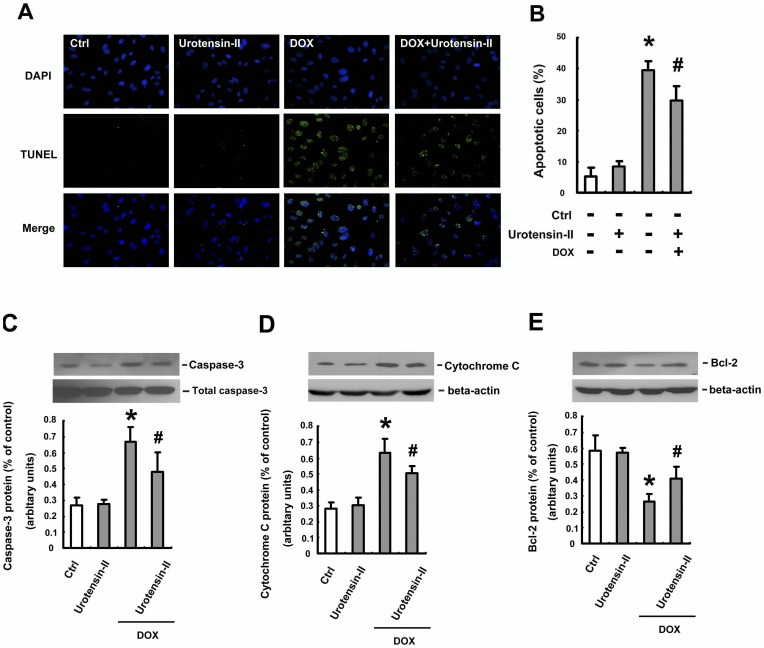
Effect of U-II on DOX-induced HUVECs apoptosis.HUVECs were incubated with DOX (1 µM) in the presence or absence of 10 nM U-II for 24 h. (A) Top: cells stained with DAPI. Middle: cells stained using TUNEL assay. Bottom: cells stained using merger. (B) Flow cytometric analysis showed that pretreatment with U-II at 10 nM significantly reduced DOX-induces cell apoptosis. The pretreatment with U-II at 10 nM significantly reduced the quantity of cleaved caspase-3 (C) and cytosol cytochrome c (D), compared with that in DOX-treated alone cells. (E) Cells were treated with DOX (1µM) in the presence of U-II (10 nM M) and Bcl-2 expression was upregulated. Densitometric data are means ± SEM from three separated experiments. *P <0.05 vs. control (Ctrl); #
P <0.05 vs. DOX treatment.